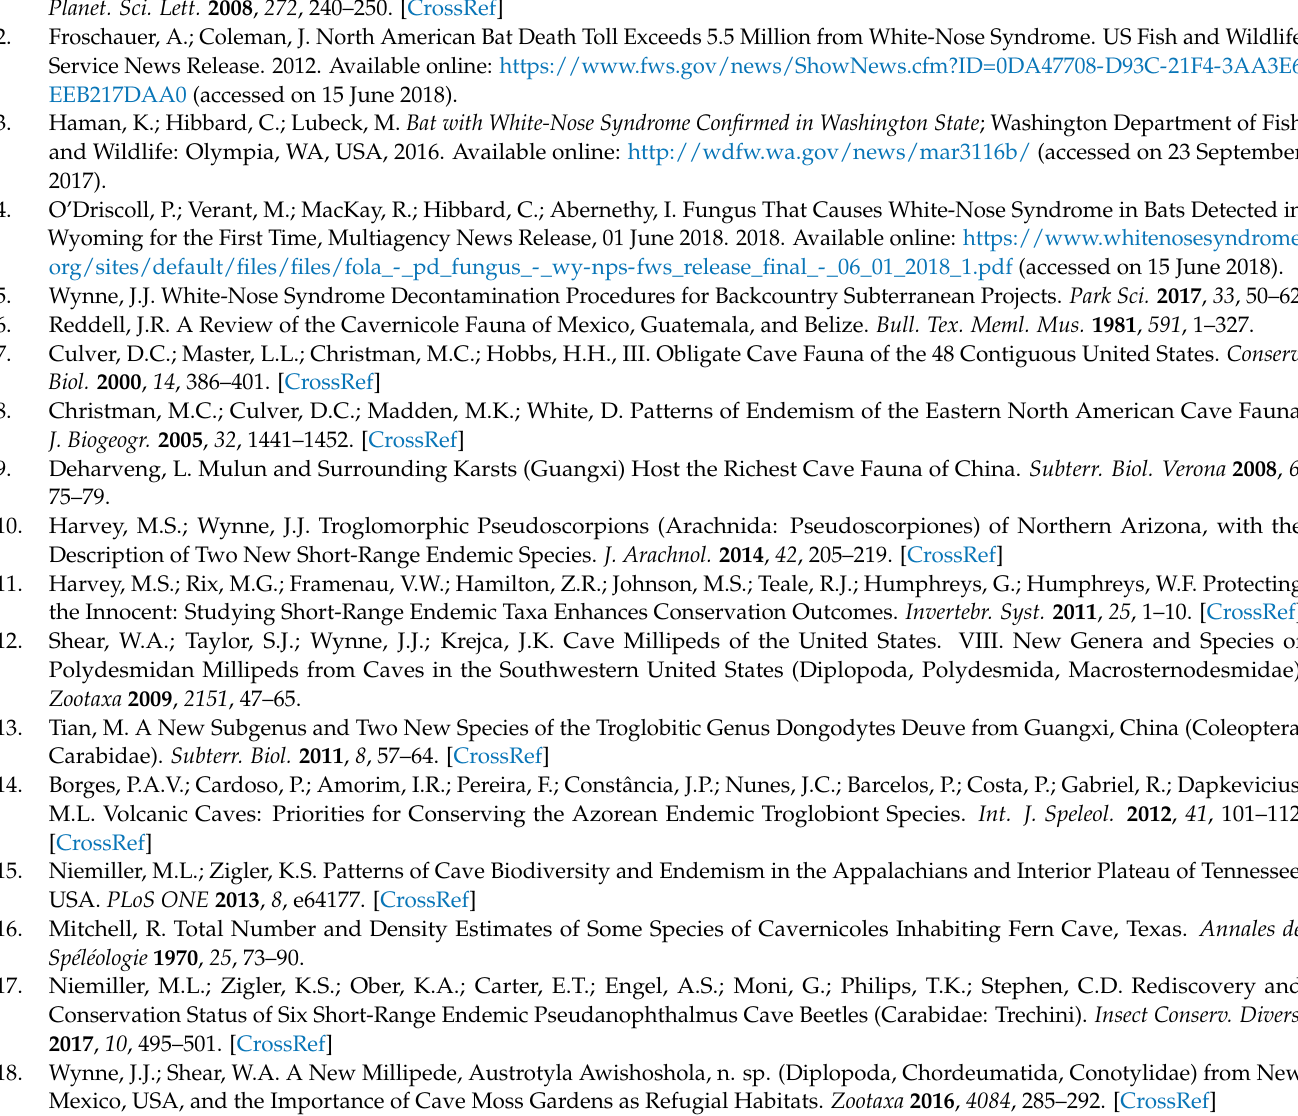
from the B Cave, Station 7 trench, and combined datasets as shown in Table A2. Solid and dashed lines are for predawn and midday atmospheric conditions, respectively. Box plots show the comparison between 2011 DN range of values (Table A3) and the 2010 surface temperature range of values (Table A4). Top and bottom of vertical line (or whisker) represent maximum and minimum DN values, while upper and lower horizontal lines of the box represent the upper and lower quartiles for DN values; horizontal line within the box is the median DN value. Horizontal whisker, vertical bounding lines of boxes, and the vertical line at center represent minimum and maximum surface temperatures, upper and lower quartiles of surface temperature, and median surface temperature, respectively. Note: Box plot at bottom right is small due to low variation in predawn DN levels; thus, the box appears filled. Instrument bias has been increased by 4500 DN. The gain was not adjusted as we cannot determine if the April 2011 surface temperatures were higher or if the gain factor was slightly higher. It is likely that both occurred. A distinct gap for both surface temperature and measured DN levels exists between the midday and predawn data, suggesting that “topographical” indices that depend on midday and predawn differences should be robust even with some variation in surface temperatures during the overflight